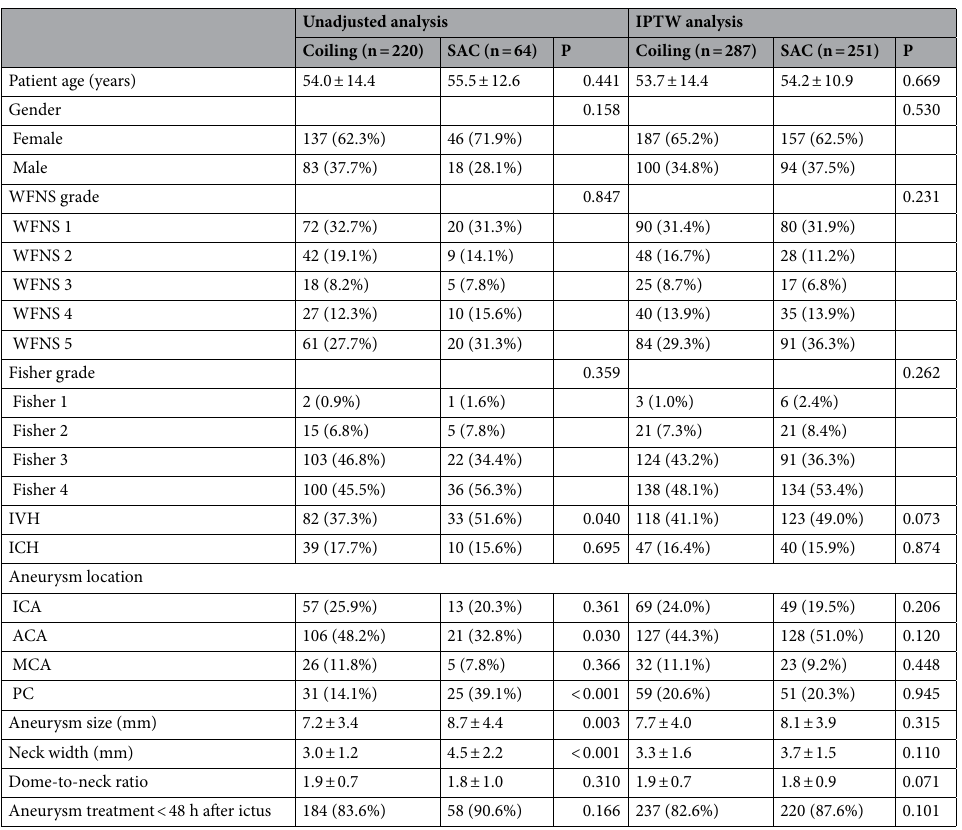
Table 1. Baseline patient and aneurysm characteristics. IPTW, inverse probability of treatment weighting; SAC, stent-assisted coiling; WFNS, World Federation of Neurosurgical Societies grading scale; IVH, intraventricular haemorrhage; ICH, intracranial hemorrhage; ICA, internal carotid artery; ACA, anterior cerebral artery; MCA, middle cerebral artery; PC, posterior circulation.